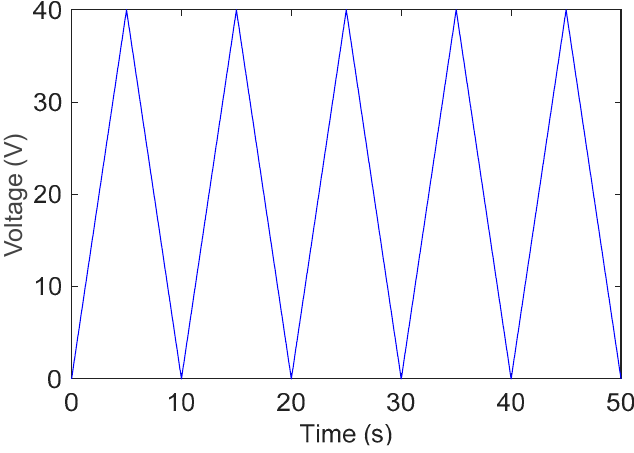
Figure 10. Triangular wave signal.